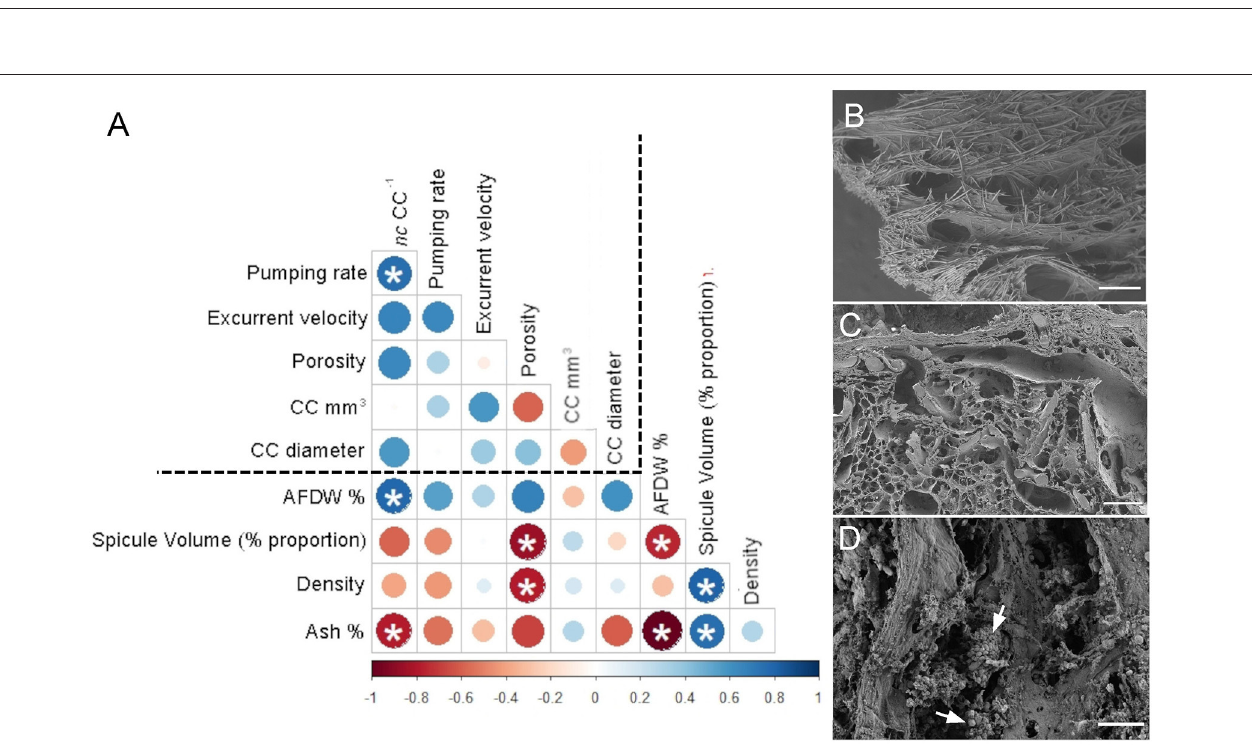
FIGURE 3 | (A) Correlation matrix summarizing all pairwise comparisons between structural components, filtration apparatus, and pumping parameters. The intensity of the color and the size of the circle indicate the strength of the correlation, with red being negative and blue being positive. The dashed line separates the variables related to structural components from the filtration apparatus and pumping parameters. Significant relationships ( p < 0.05) are marked with an asterix (B) Amorphinopsis feotida tissue with spicules (C) Ircinia fusca tissue without any spicules (D) Calyspongia sp. with the empty spaces around the choanocyte chambers. White arrows point to choanocyte chambers. [scale (A) = 500 µ m, (B) = 100 µ m, (C) = 20 µ m].